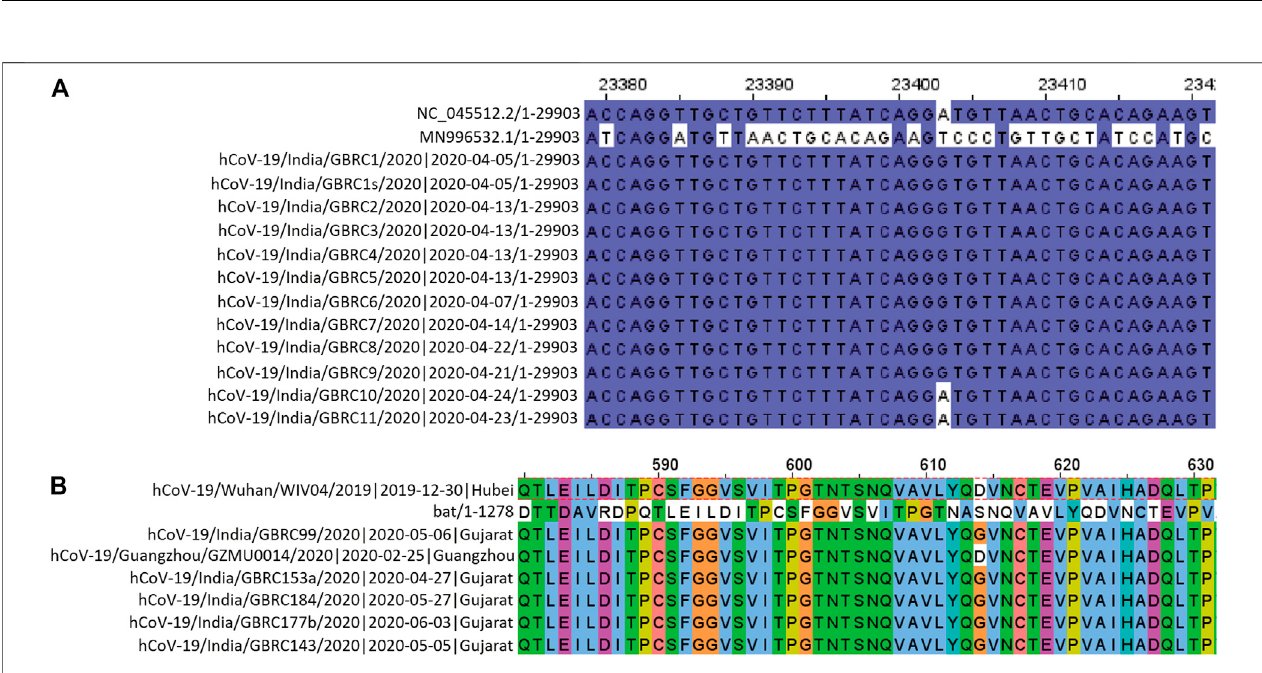
FIGURE1| Nonsynonymousmutationsasobserved (A) intheanalysedSARS-CoV-2genomes( n (cid:1) 2,439)fromGujaratregion(submissionsbyGBRC)compared to the Wuhan SARS-CoV-2 reference, scale represents the number of genomes, those highlighted in red are speci fi c to the spike glycoprotein, (B) in the spike glycoprotein of the sequences from Gujarat ( n (cid:1) 2,439) and globally ( n (cid:1) 3,897,179) in terms of their percent occurrence as on September, 2021.